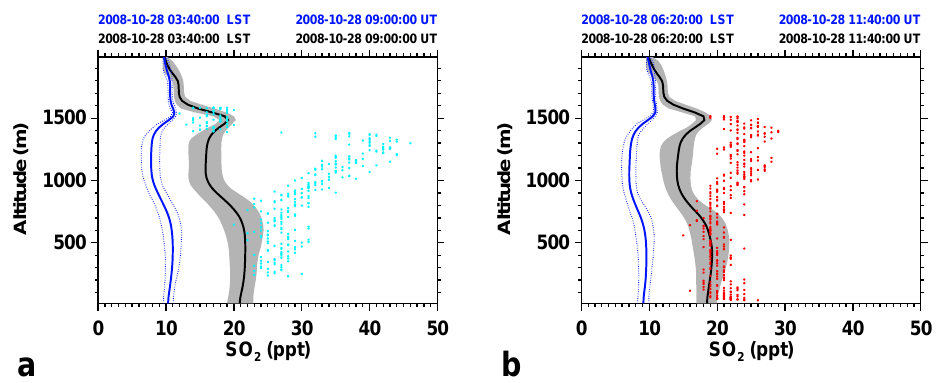
Fig. 11. Comparison of SO 2 from simulation S 0 (black) and S 1 (blue) at (a) 09:00UT and (b) 11:40UT with VOCALS-REx RF06 POC observations at 09:05UT (cyan dots) and at 11:36UT (red dots) on board the NCAR C-130 aircraft. Solid curves denote the model mean, gray shading and dotted blue curves model values between the 10th and 90th